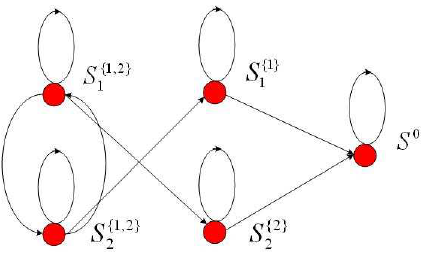
Figure 42. State transition diagram when M = 2 .